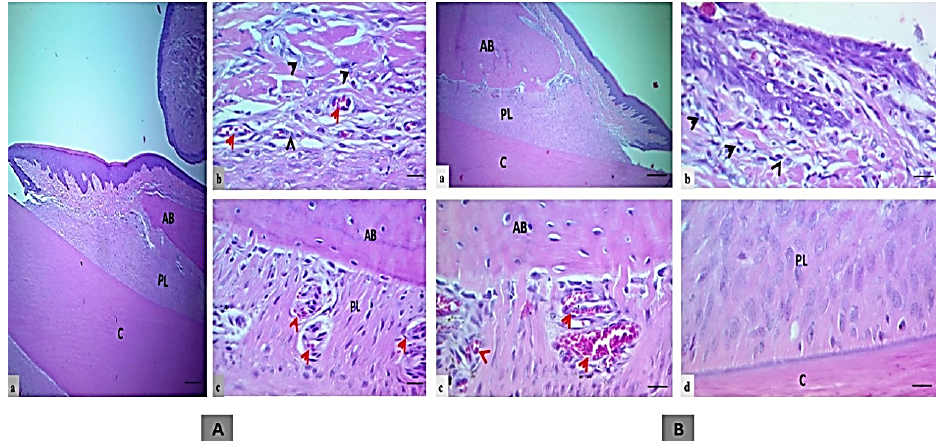
Figure 2. The histologic section of an incisor tooth and periodontal tissue of rats. ( A ) Treatment control group, a and b. Intact junctional epithelium with mild inflammatory cells (black head arrows) in the insertion point, c. Regular bone surface with well-formed dense bone, a wide periodontal ligament space of uniform thickness filled with organized proliferating periodontal ligament tissue attached to a regular cementum surface and multiple blood vessels (red arrow, H&E, scale bar 10 µ m in section a, and 20 µ m in section b and c). ( B ) EOK or tested treatment group, a and b. Intact junctional epithelium with mild inflammatory cells (black head arrows) in the insertion point (section b), c. Regular bone surface with well-formed dense bone, and dilated blood vessels (red arrow), d. A wide periodontal ligament space of uniform thickness filled with less organized proliferating periodontal ligament tissue attached to a regular cementum surface (H&E, scale bar 10 µ m in section a, and 20 µ m in section b–d). (AB; alveolar bone, PL; periodontal ligament and C;